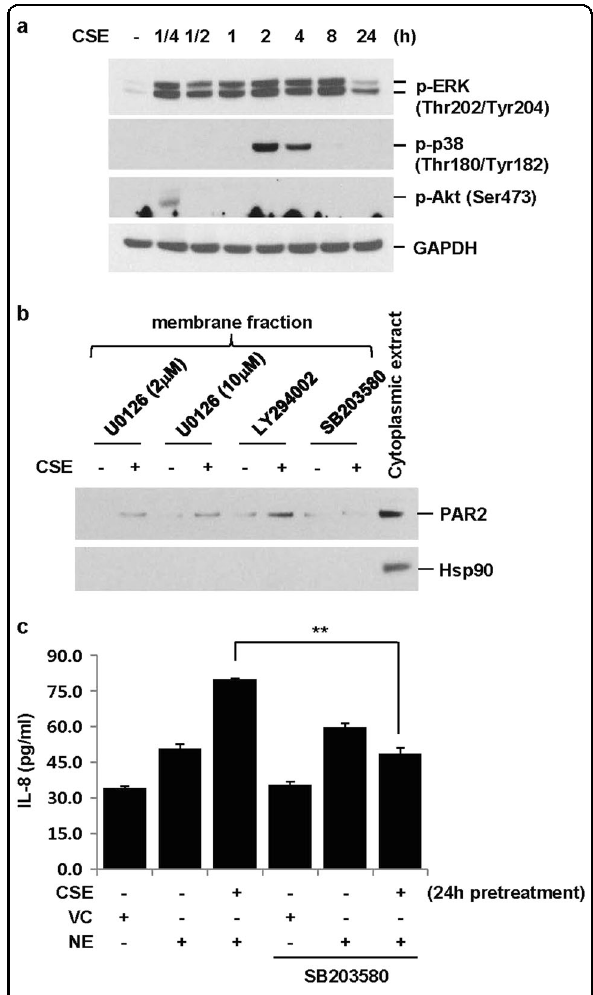
Fig. 4 CSE-induced upregulation of PAR2 is dependent on p38 activation. a BEAS-2B cells were treated with CSE (1%) for the indicated times. Total cellular extracts were subjected to western blot analysis for p-ERK, p-p38, p-Akt, and GAPDH. b Cells were pre-treated with an MEK inhibitor (U0126, 2 or 10 μ M), PI3K/Akt inhibitor (LY294002, 10 μ M), or p38 inhibitor (SB203580, 10 μ M) for 2 h and then stimulated with CSE for 24 h in the presence of U0126, LY294002, or SB203580. Membrane and cytoplasmic proteins were extracted and subjected to western blot analysis for PAR2 and heat shock protein 90 (Hsp90). c BEAS-2B cells were pre-treated with SB203580 (10 μ M) for 2 h and then stimulated with CSE (1%) in the presence or absence of SB203580 for 24 h. The cells were stimulated with VC or NE (1 U/ml) for 24 h in the absence of SB203580 and CSE. IL-8 concentrations in cell supernatants were measured by multiplex bead assay. Data represent the mean ± SD; ** P <